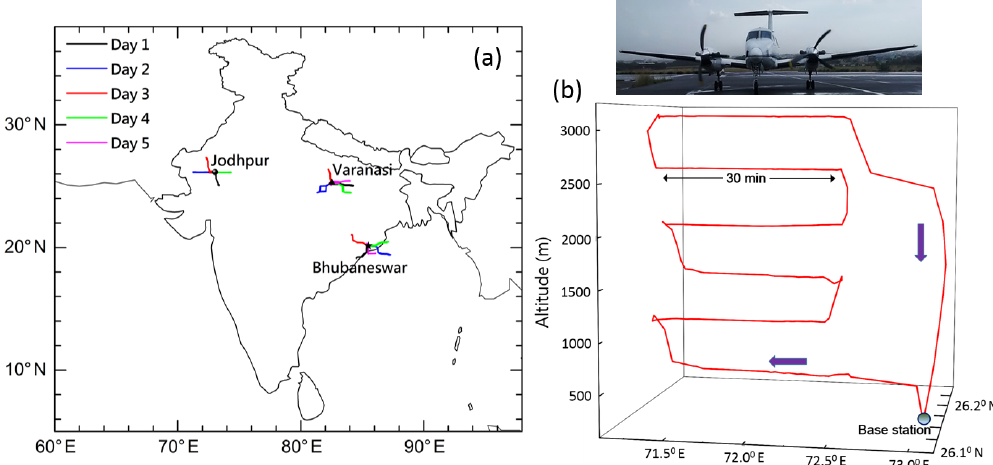
Figure 2. (a) Base stations for the aircraft sorties with the track of each sortie superimposed. (b) A typical sortie pattern (staircase) which represents all the sorties carried out during the experiment and the photograph of NRSC